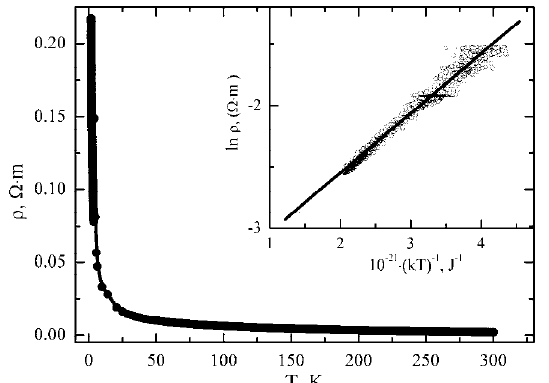
Fig. 3. A temperature dependence of the resistivity of InSb-MnSb film. Inset: linear segment of the plots of ln ρ versus ( kT ) -1